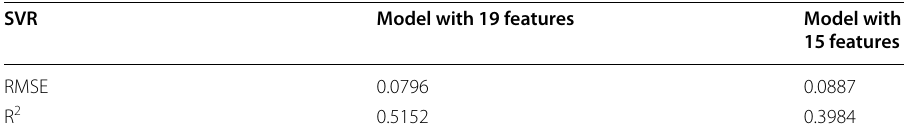
Table 7 Performance metrics with SVR SVR Model with 19 features